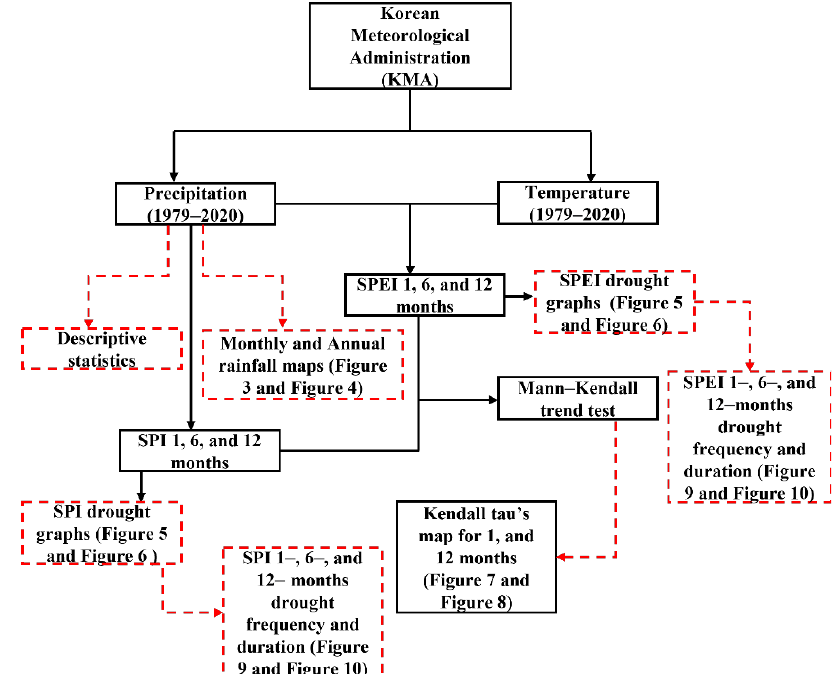
Figure 2. Flowchart of the research .